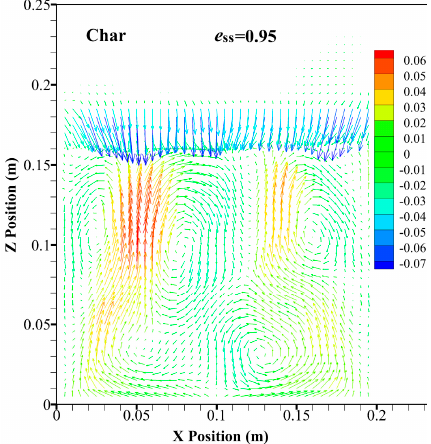
Figure 9. Time-averaged particle velocity distribution of the flotsam for e ss = 0.95 (the color legend represents the axial velocity of the particles).